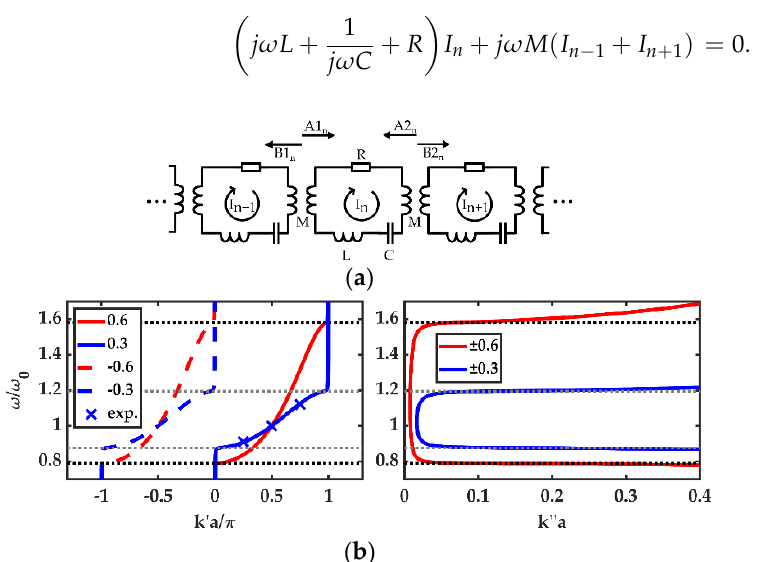
Figure 1. Magnetoinductive (MI) waveguide: ( a ) equivalent circuit; ( b ) frequency dependence of 𝑘’𝑎 and 𝑘’’𝑎 for κ = {±0.6,±0.3} and Q = 200 . Crosses show measured points for 𝜅 = 0.3 .